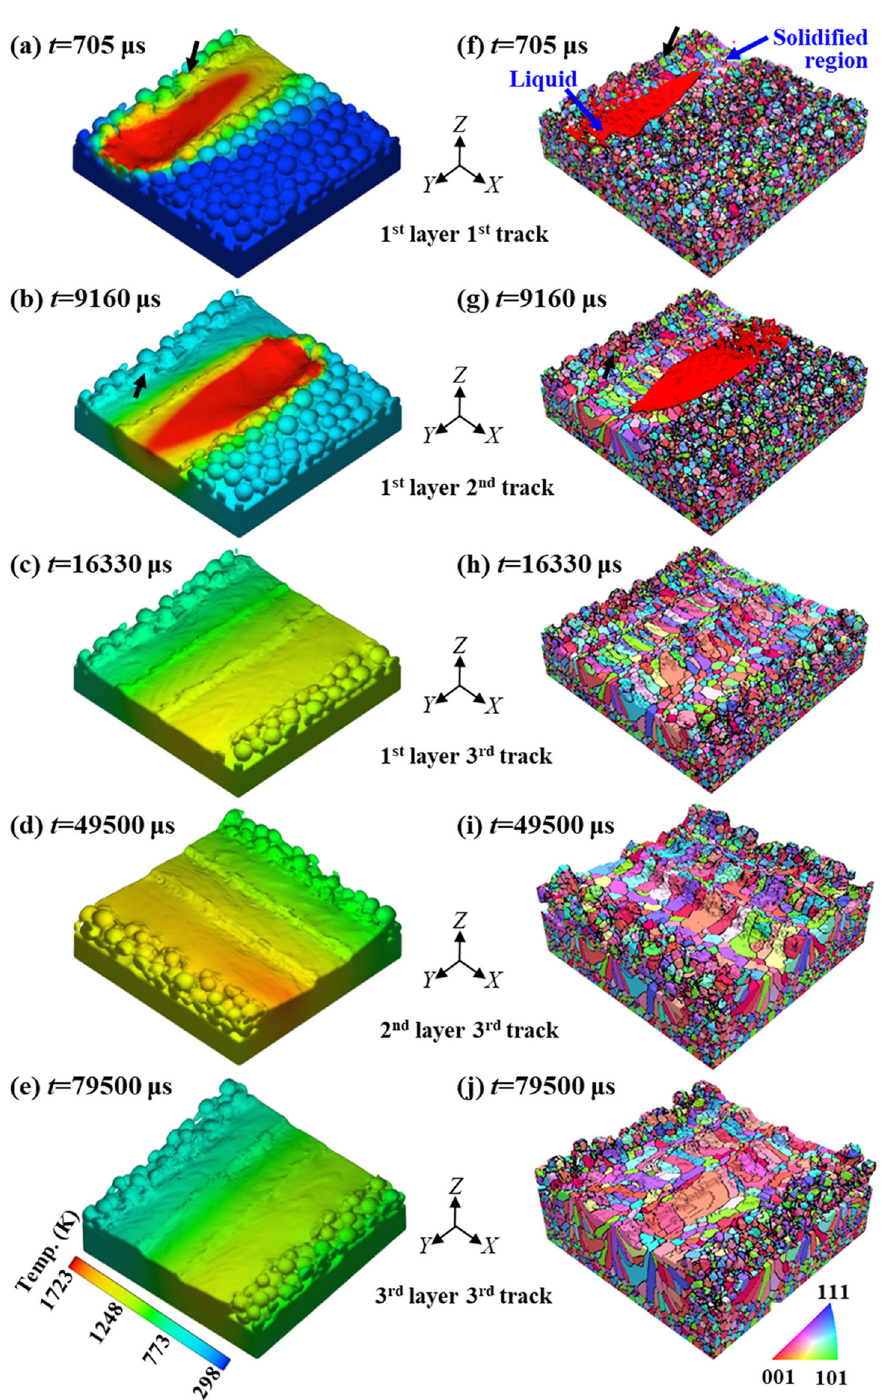
Fig. 2 Evolutions of temperature fi eld and grains during the three-layer three-track SLM process. a – e Temperature fi eld evolution; f – j grain evolution. The red regions in a and b show the molten pool morphologies in the two tracks. The scanning direction rotates 90 o between adjacent layers. Partially melted powder particles are highlighted by the black